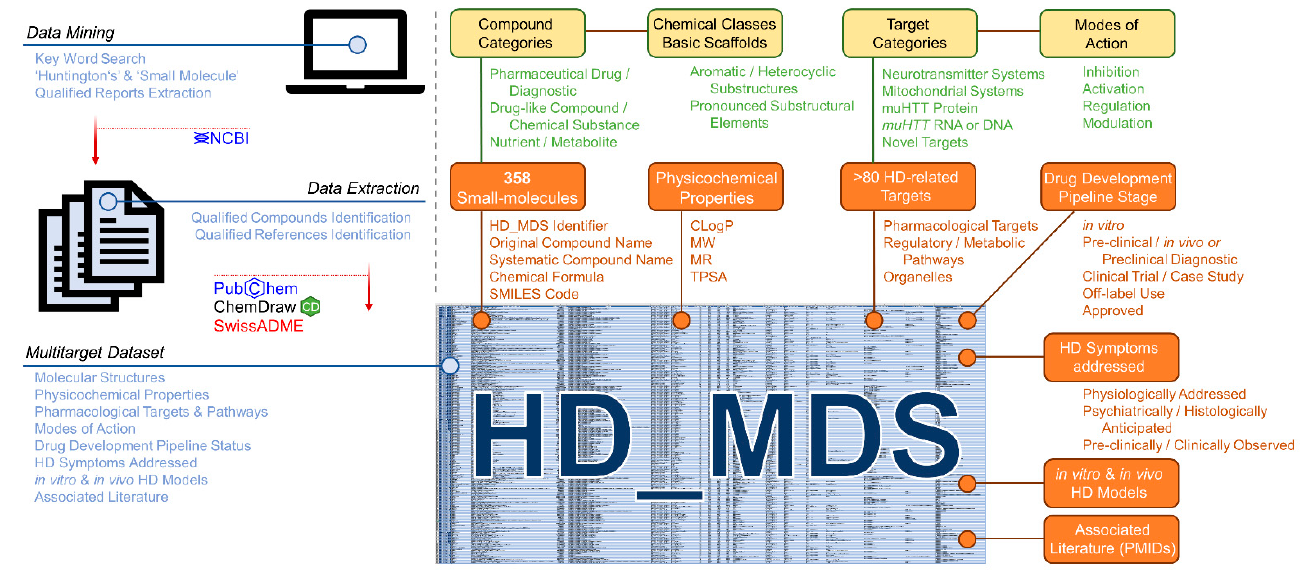
Figure 10. Schematic representation of the establishment of the Huntington’s Disease Multitarget Dataset (HD_MDS, Supplementary Material Table S1).